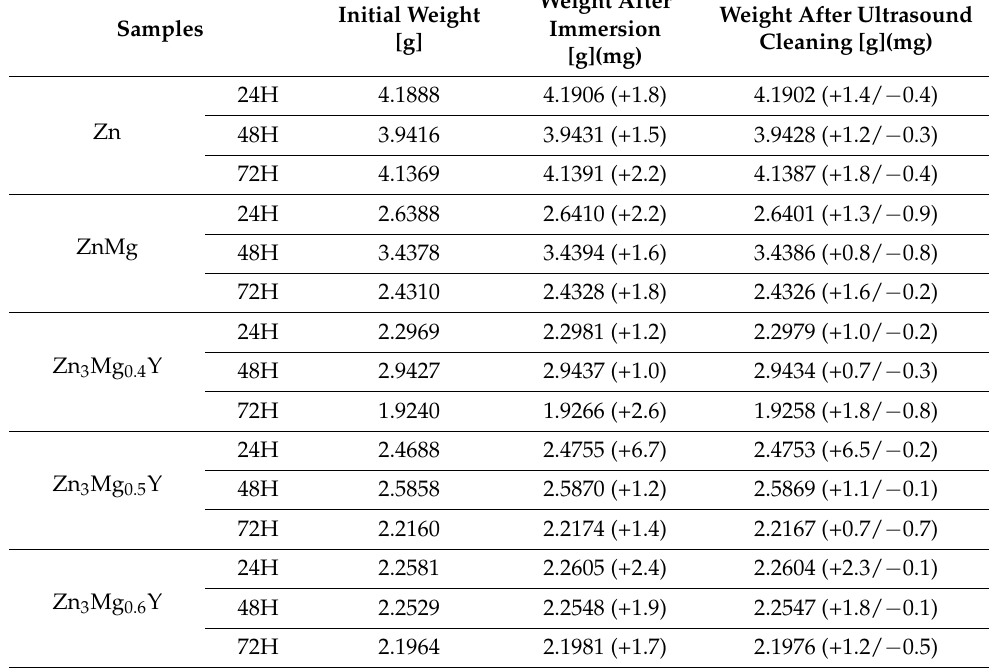
Table 3. Weights of samples after the immersion